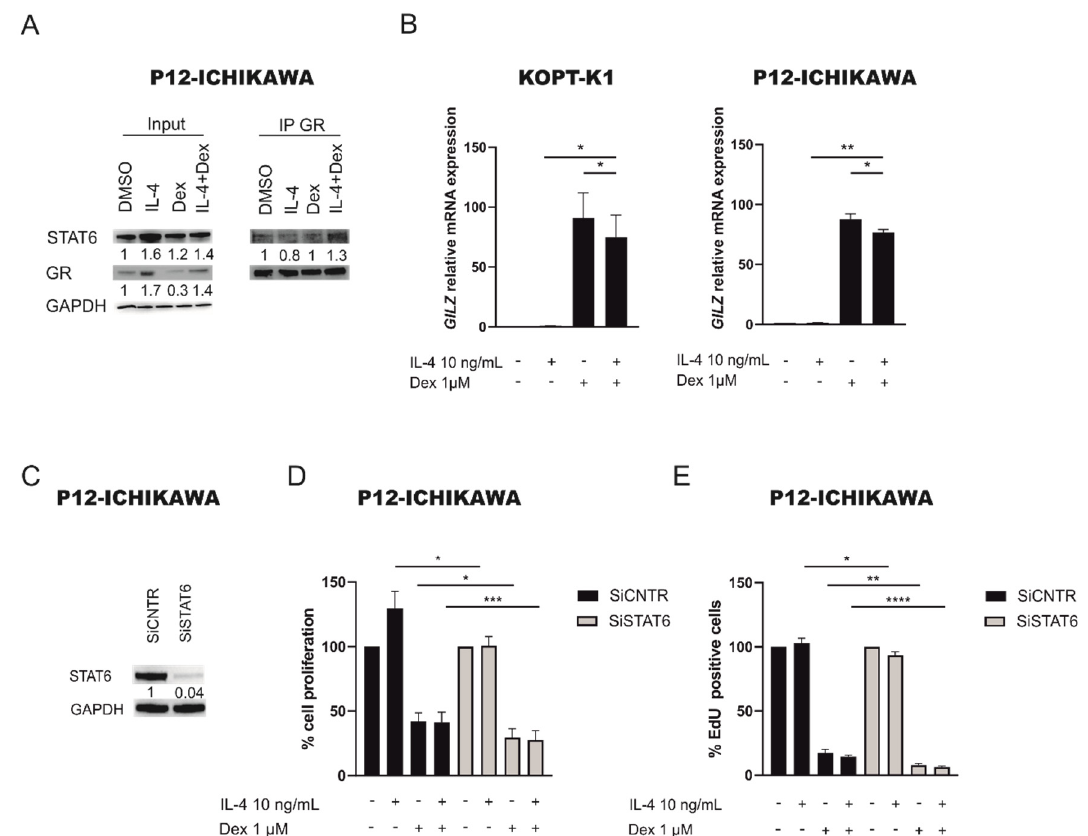
Figure 3. STAT6 binds GR and inhibits its transcriptional activity. ( A ) Co-immunoprecipitation of GR and STAT6 protein in P12-ICHIKAWA cells treated with DMSO, IL-4 (10 ng/mL) or dexamethasone (1 μ M) alone, or the combination of IL-4 and dexamethasone. ( B ) GR transcriptional activity measured by GILZ mRNA levels in P12-ICHIKAWA and KOPT-K1 cells DMSO treated, stimulated with IL-4 (10 ng/mL ON), dexamethasone (1 μ M for 6 h) or the combination of IL-4 and dexamethasone. Results are presented as means ± SEM ( n = 3). ( C ) WB analysis of STAT6 protein expression in P12-ICHIKAWA SiCNTR and SiSTAT6 after 48 h silencing. ( D ) Cell proliferation determined by MTT test in P12-ICHIKAWA siCNTR (black bars) and in SiSTAT6 (grey bars) followed by treatment with IL-4 (10 ng/mL) or dexamethasone (1 μ M) alone or in combination. Cell proliferation of control DMSO treated cells was set to 100%. ( E ) Percentage of EdU positive cells in P12-ICHIKAWA siCNTR (black bars) and in SiSTAT6 (grey bars) followed by treatment with IL-4 (10 ng/mL) or dexamethasone (1 μ M) alone or in combination. Results are presented as means ± SEM (at least n = 3 for all the experiments) (* p < 0.05; ** p < 0.01; *** p < 0.001; **** p < 0.0001. paired t test).